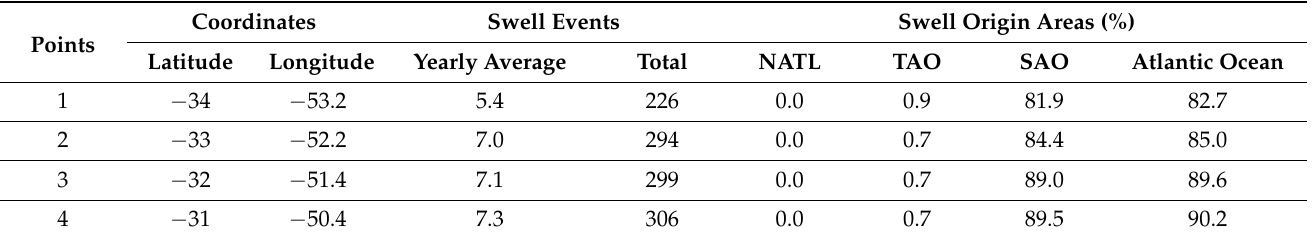
Table A1. Coordinates of the points used in the swell-event analysis and their respective annual mean number of swell events, total number of swell events, and percentages of swells (%) coming from each storm-originating area in the Atlantic Ocean: North Atlantic Ocean (NATL), Tropical Atlantic Ocean (TAO), and South Atlantic Ocean